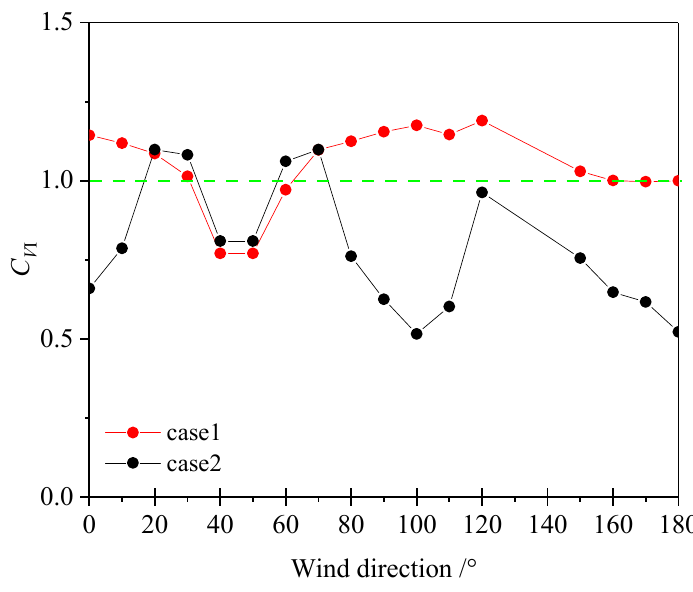
Figure 10. Variation of CVI with wind direction of PFAC.